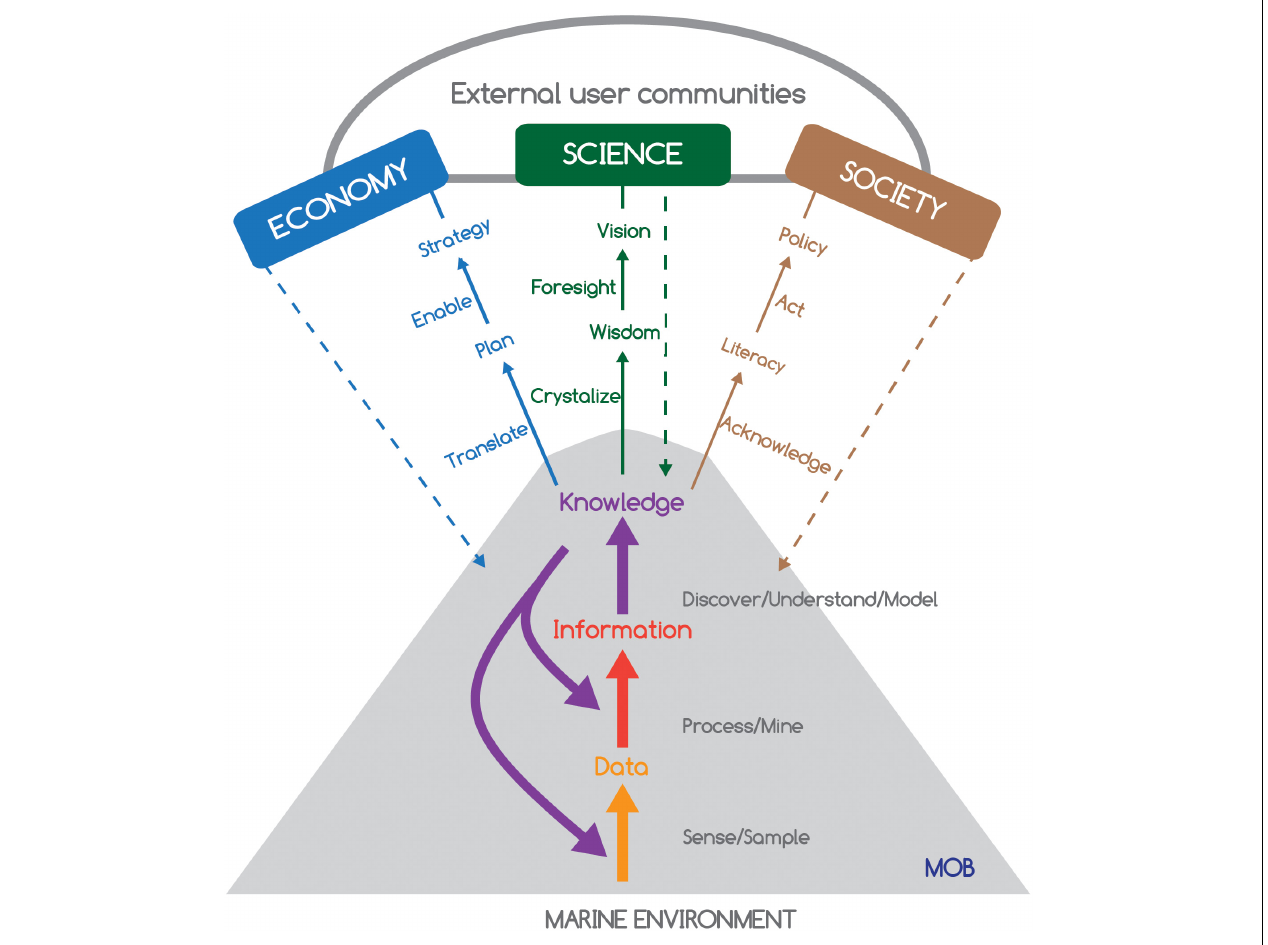
FIGURE 2 | MOB-based hierarchy of understanding for science, society, and economy. The MOB generate knowledge by sensing the environment thus creating data that are then processed to become information that is distilled into knowledge. From MOB, user-specific pathways will elaborate and translate knowledge to the external user communities (Economy, Science, and Society). The triangle is the MOB domain, the arrows are processes that link one level of understanding to another, dashed arrows are the feedbacks from the external user communities to the MOB and thick arrows are feedbacks within the MOB. The hierarchy of understanding is modified from Carpenter and Cannady